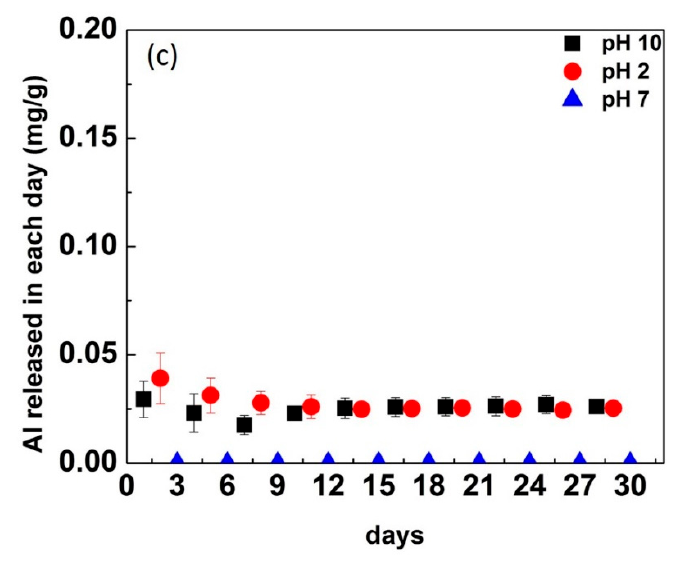
Figure 3. The cumulative Al 3+ ion released in each condition ( a ) and the Al 3+ released in each pH and time individually in ( b ) 3-d cycling and ( c ) 1-d cycling.